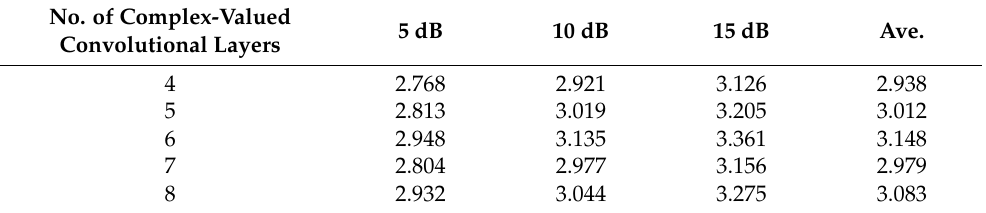
Table 5. The PESQ scores for models with different complex-valued convolutional layers. No. of Complex-Valued